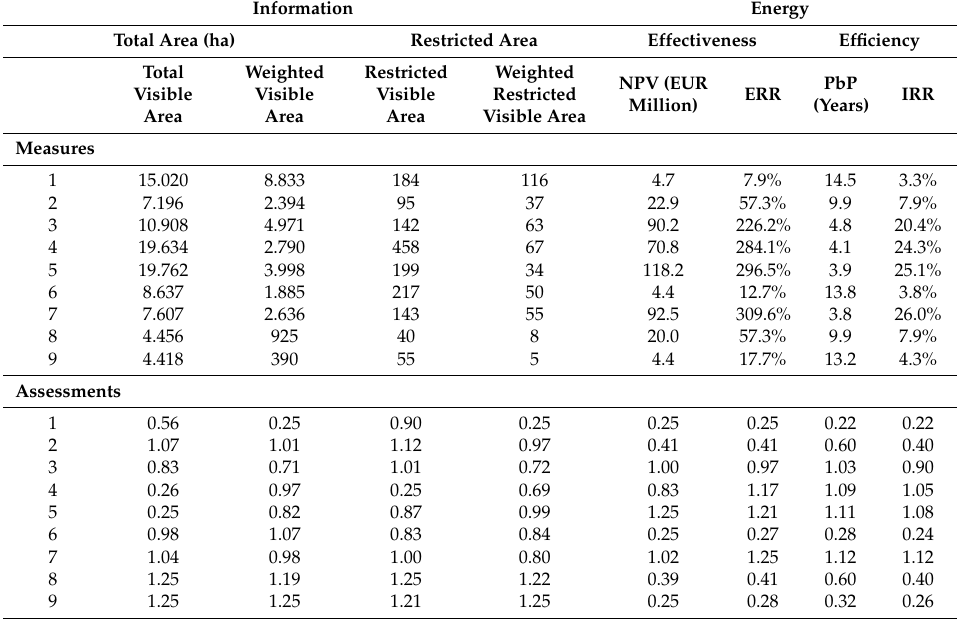
Table 4. Quantitative and qualitative assessment terms of the nine plants considered in the province of Siracusa.